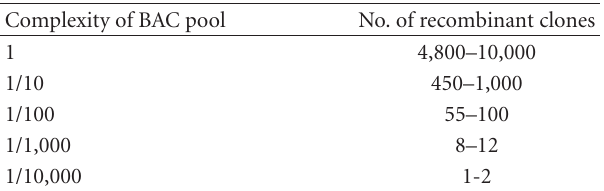
Table 1: Selectivity of recombination from BAC pools in DY380 cells using 100ng of linear recombination cassette.